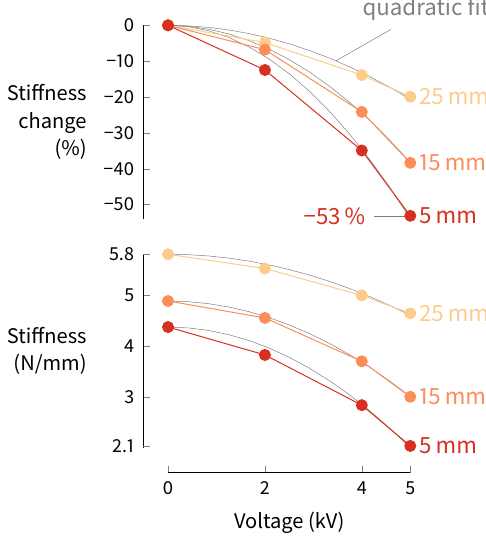
Figure 7. Our DET VSA softened approximately quadratically with the applied voltage up to 53%. These values were calculated from the rising tension portion of the third cycles of the trajectories shown in Figure 6 by dividing the force at [5, 15, 25]mm by the corresponding displacement. Because the DET stiffness is quadratically dependent on voltage, quadratic fits using only a quadratic term and a constant term equal to the initial point are plotted for comparison with the experimental